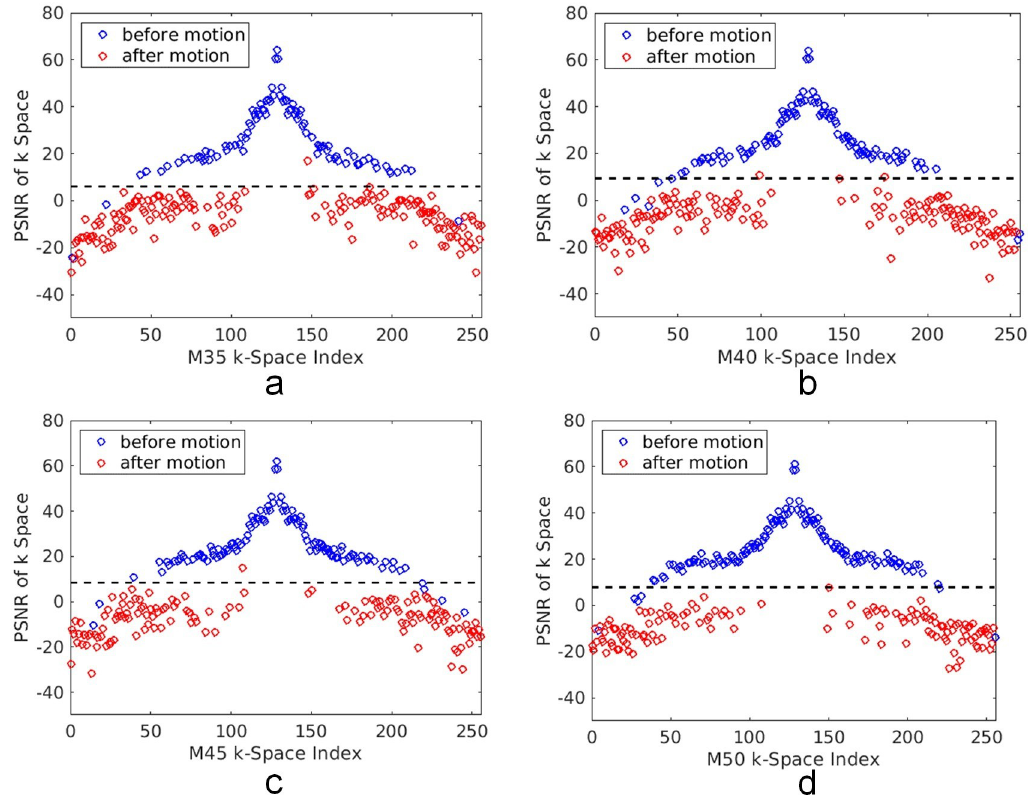
Fig 4. The examples of PSNR k between the PE lines of the motion-corrupted k-space and filtered k-space for each of the four motion modes. (a)–(d) show the calculated PSNR k values for M35, M40, M45 and M50, respectively. Blue circles and red circles represent the PE lines sampled before and after the motion started, respectively. The horizontal dashed line visualizes the threshold determined by Otsu’s method for splitting the calculated PSNR k values into two groups. It can be seen most of the lines not affected by the motion stay above the threshold, except for a few lines in the high-frequency